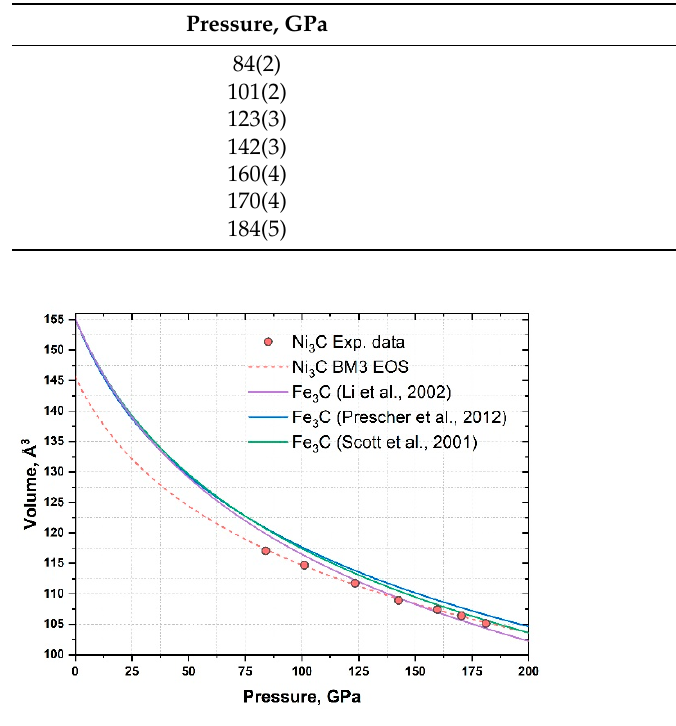
Figure 4. The pressure-volume dependence of Ni 3 C. Red dots represent experimental data, the dashed red curve is the BM3 EOS fit (V 0 = 147.7(8) Å 3 ; K 0 = 157(10) GPa, K (cid:48) = 7.8(6)). Solid purple, blue and green lines correspond to the EOSes of Fe 3 C from studies of Li et al. (K 0 = 174(6) GPa, K (cid:48) = 4.8(8)) [31], Prescher et al. (K 0 = 161(2) GPa, K (cid:48) = 5.9(2)) [32] and Scott et al. (K 0 = 165(4) GPa, K (cid:48) = 5.99(9)) [33]. Table 2. The pressure dependence of the unit cell parameter of Ni 3 C. Values in parentheses correspond to experimental uncertainties.